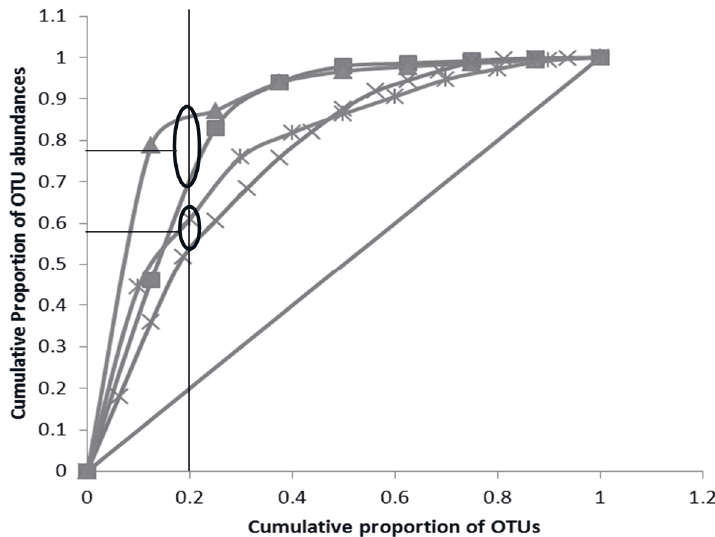
Figure 4. PL curves representing from Week 1 to Week 4 oftreatment O (seawater + BH medium + weathered crude oil). (“